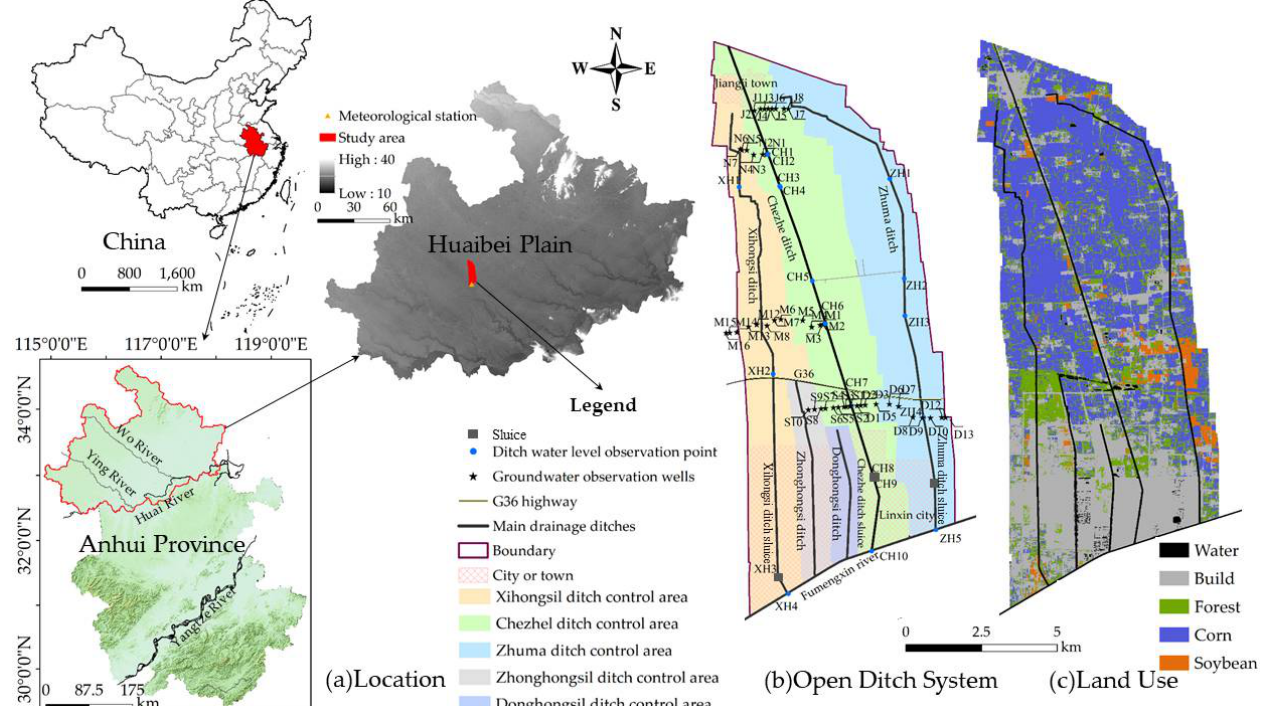
Figure 1. Overview of the study area, where ( a ) shows the location of the study area, the topographic map of Anhui Province was obtained from the National Administration of Surveying, Mapping and Geographic Information of the People’s Republic of China (http://www.nasg.gov.cn/ (accessed on 15 May 2022). The DEM source of the NHRP was obtained from the NASA (National Aeronautics and Spacing Administration) website (http://reverb.echo.nasa.gov/reverb/ (accessed on15 May 2022)); ( b ) shows the open ditch system in study area; and ( c ) shows the land use of study area.